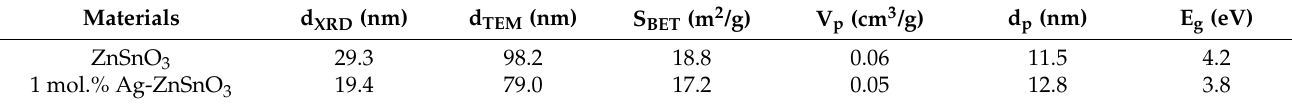
Figure 1. ( a ) XRD patterns, and ( b ) FTIR spectra of ZnSnO 3 , and Ag-ZnSnO 3 sample materials. Table 1. Textural/structural and morphological characteristics of synthesized sample materials x,y